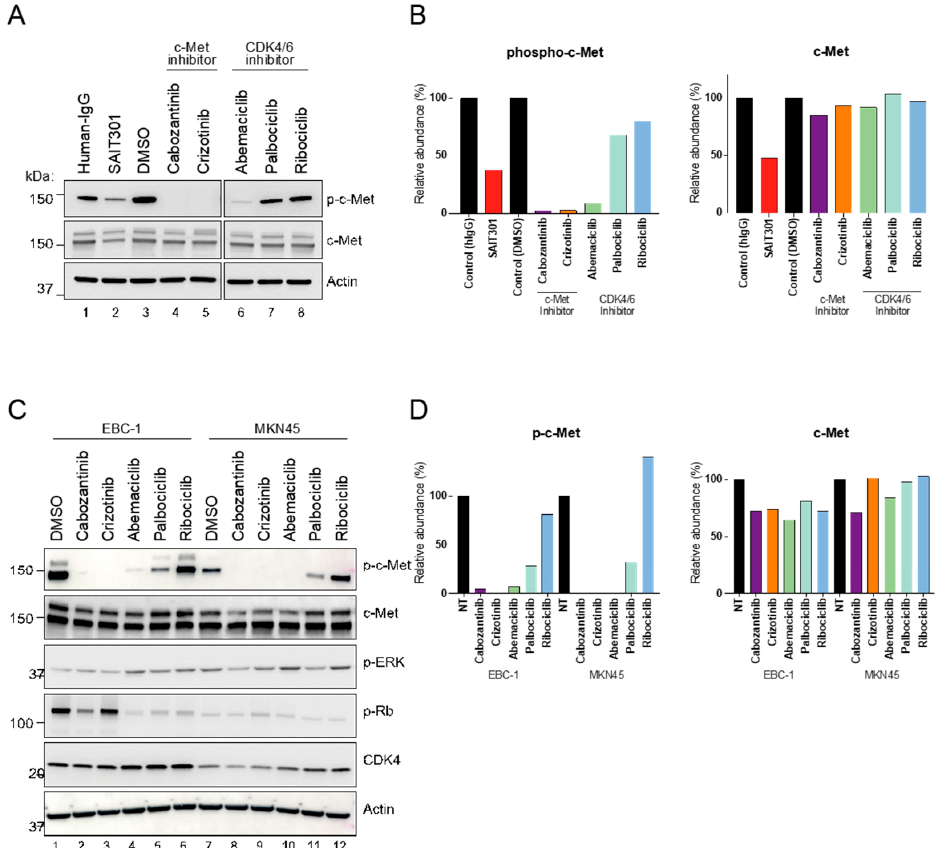
Figure 4. Distinct role of abemaciclib in regulation of c-Met activity. ( A ) PDC6 were treated with 10 µ m of cabozantinib, crizotinib, abemaciclib, palbociclib, and ribociclib, and 100 nM of SAIT301